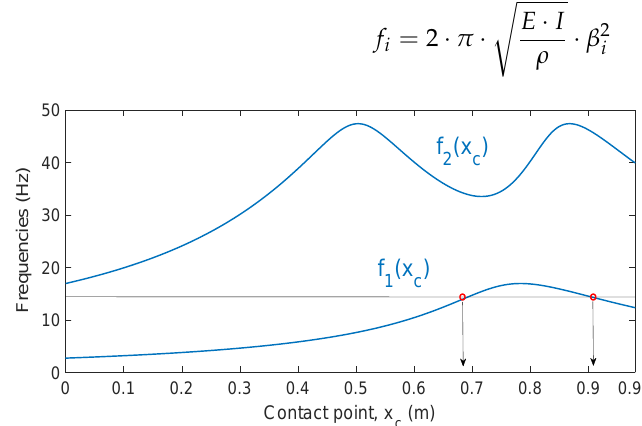
Figure 8. Frequencies of the